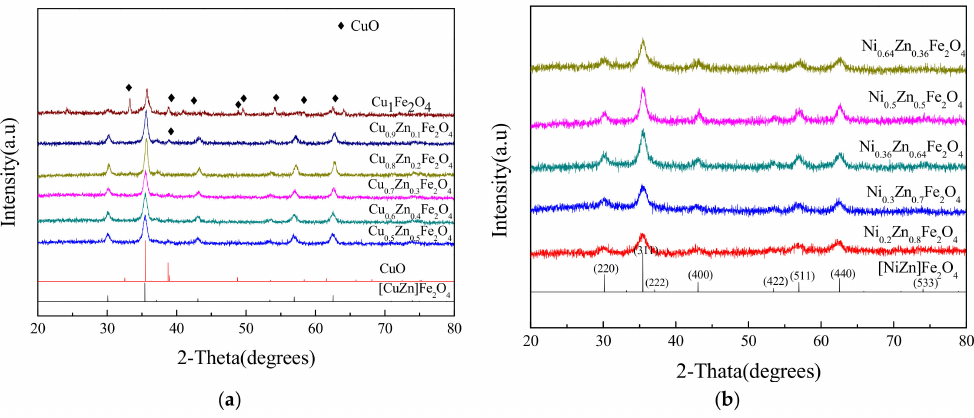
Figure 2. The X-ray powder diffraction (XRD) patterns of [M x Zn 1 − x ] Fe 2 O 4 sintered at 600 ◦